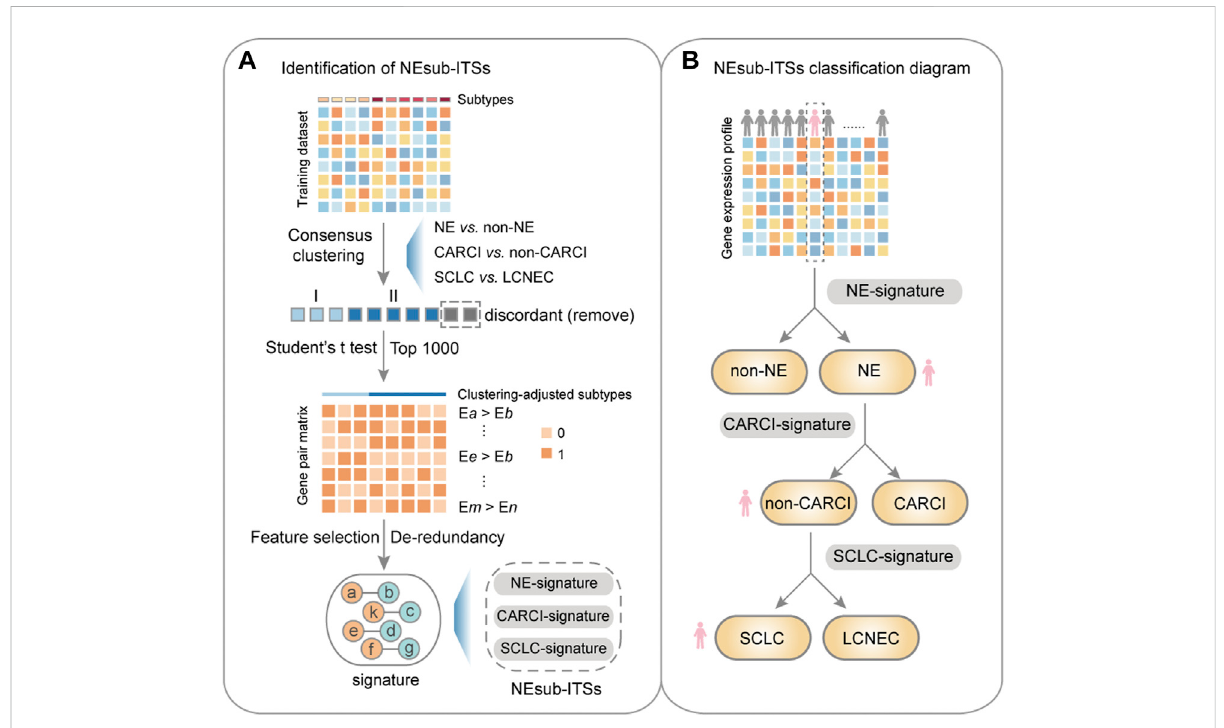
FIGURE 3 Flowchart of this study. (A) identi fi cation of the NEsubtype-panel. First, in the training dataset (GSE30219), a consensus clustering was performedbasedonmRNAexpressiontoremovethediscordantsamples,andthen,apaneloftranscriptionalsignaturesfordeterminingNEsubtype (NEsubtype-panel) in the clustering-adjusted samples was hierarchically developed, based on the “ within-sample ” relative expression orderings (REOs) of gene pairs to determine the lung NE subtypes. Second, the NEsubtype-panel was tested in multiple datasets with fresh-frozen, clinically challenging (FFPE and small biopsy specimens), and single-cell samples. At last, survival and differential expression analyses were conductedtoindirectlysupportthereclassi fi cationindicatedbythesesignatures. (B) theNEsubtype-panelclassi fi cationdiagram.Foragivensample, the NEsubtype-panel was used to classify the histological subtype step by step based on the “ within-sample ” REOs of gene pairs, and to ultimately determine the patient subtype. NE, neuroendocrine; non-NE, non-neuroendocrine; and FFPE, formalin- fi xed paraf fi